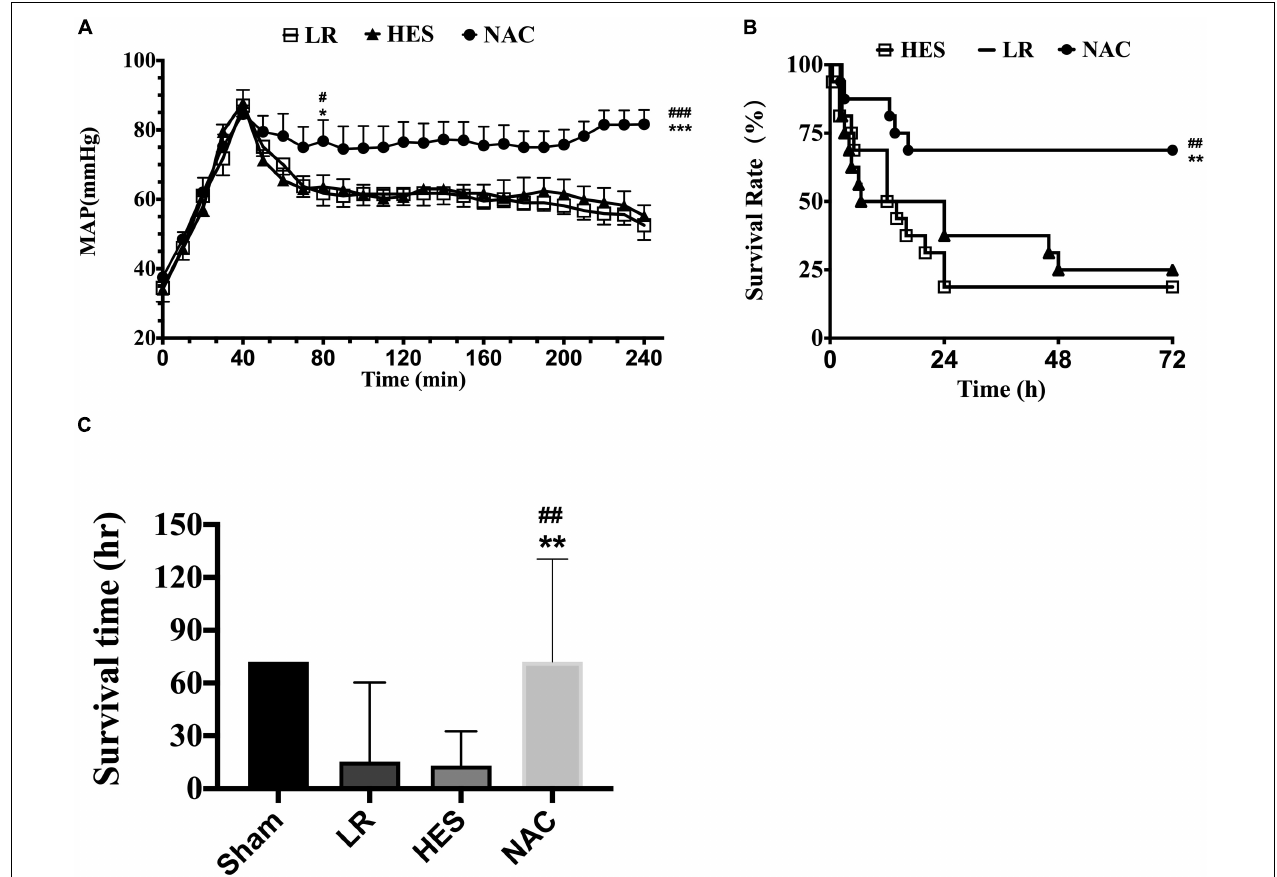
FIGURE 4 | Effects of LR solution, HES solution, and LR solution with the addition of NAC (30 mg/kg) on MAP, survival time, and 72-h survival rate. (A) MAP ( n = 8/group); (C) survival time ( n = 16/group); (B) 72-h survival rate ( n = 16/group). LR, Lactated Ringer’s; HES, Hetastarch; NAC, LR solution with the addition of NAC (30 mg/kg). Data presented as mean ± standard deviation ( n = 16/group). # P < 0.05, ## P < 0.01, ### P < 0.001, LR group versus NAC group; * P < 0.05, ** P < 0.01, *** P < 0.001, HES group versus NAC